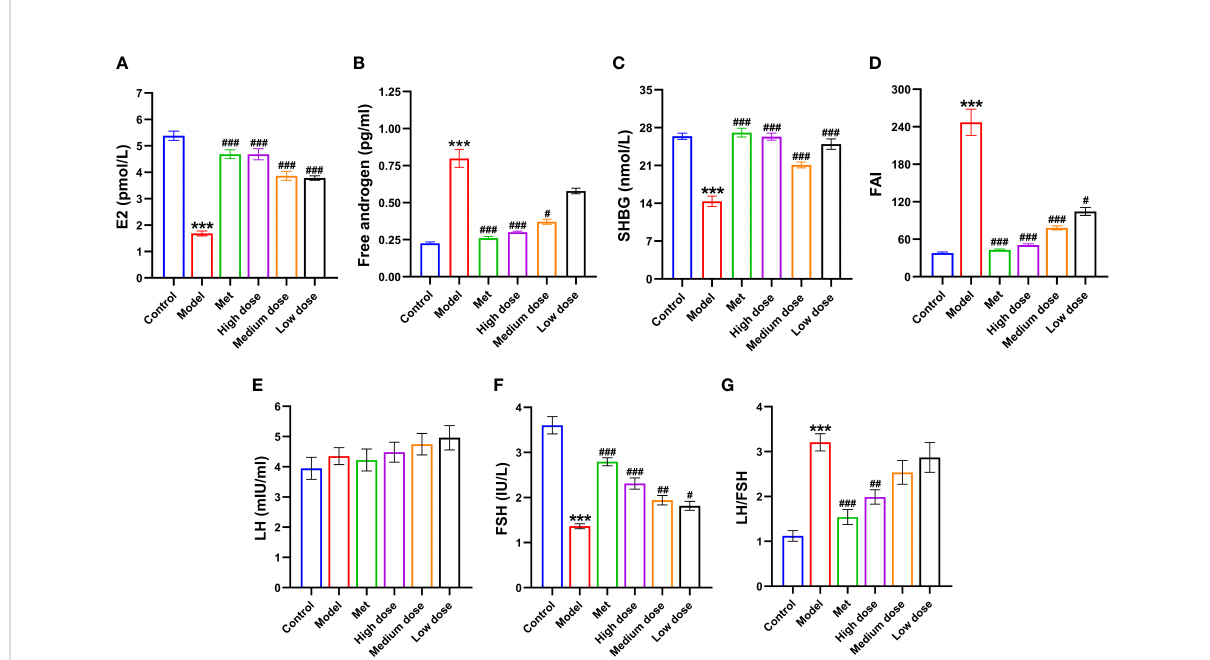
FIGURE 5 Effects of MCDD on serum factors in PCOS-IR rats. (A) Estradiol, (B) Free androgen, (C) Sex hormone binding globulin, (D) Free androgen index, (E) LH, (F) FSH, (G) LH/FSH. The serum sex hormones and other indicators of rats were measured by enzyme-linked immunosorbent assay kit. The above results are expressed as mean ± SEM, n = 10~11. *** P < 0.001, vs. control group, ### P < 0.001, ## P < 0.01, # P < 0.05, vs. model